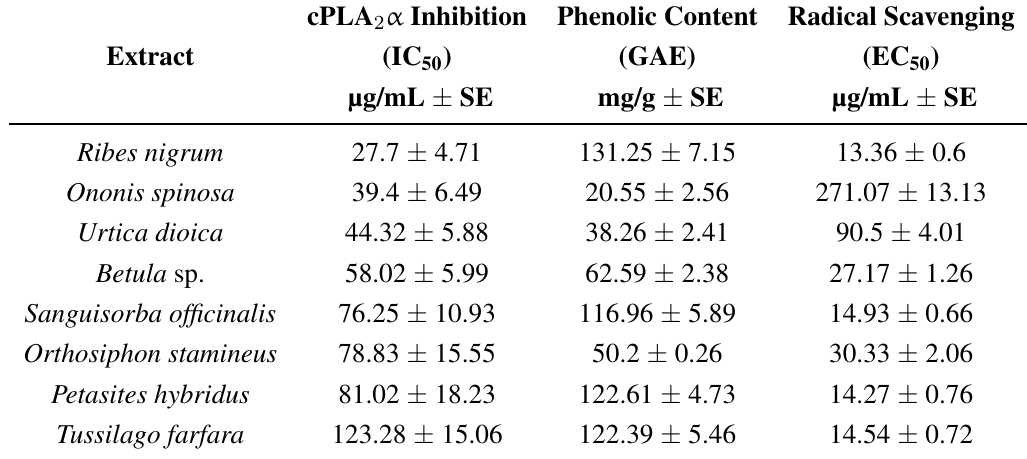
α inhibition, phenolic content and DPPH scavenging activity of Table 2. Summary of cPLA 2 α inhibition is shown as the IC the eight most potent extracts. The cPLA value (µg/mL final 2 50 extract concentration); phenolic content relates to gallic acid equivalents (GAE) in mg per g extract. The DPPH radical scavenging is shown as EC (µg/mL final extract concentration). 50 α Values are means ( n = 3) ± the standard error (SE), ordered according to their cPLA 2 inhibitory